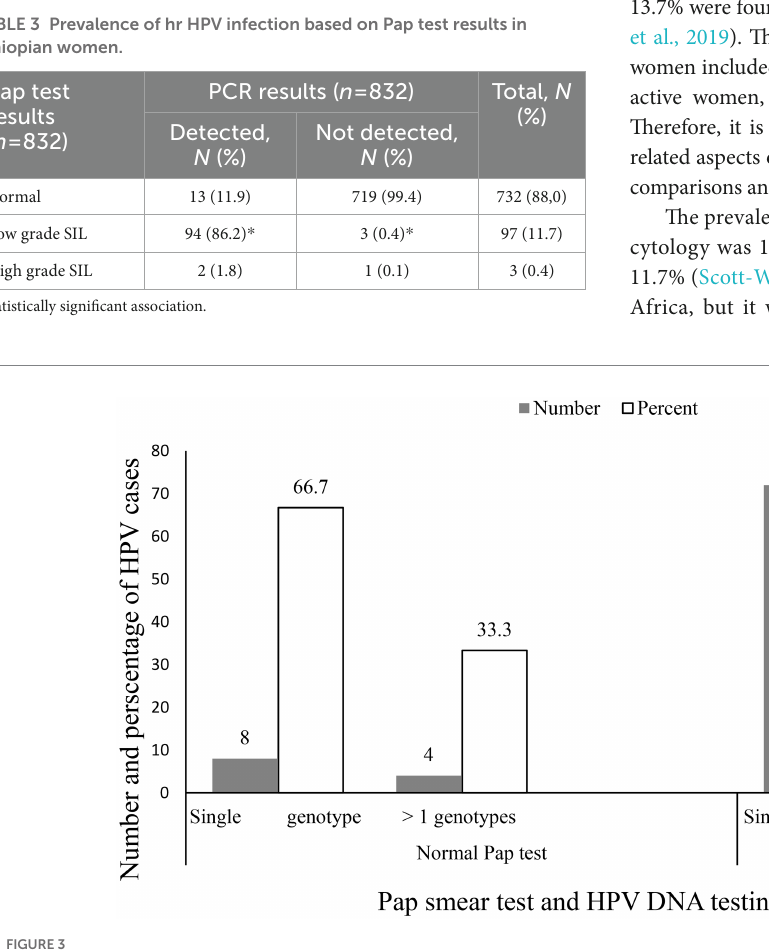
FIGURE 3 A single and co-existed genotypes of HPV within different Pap test